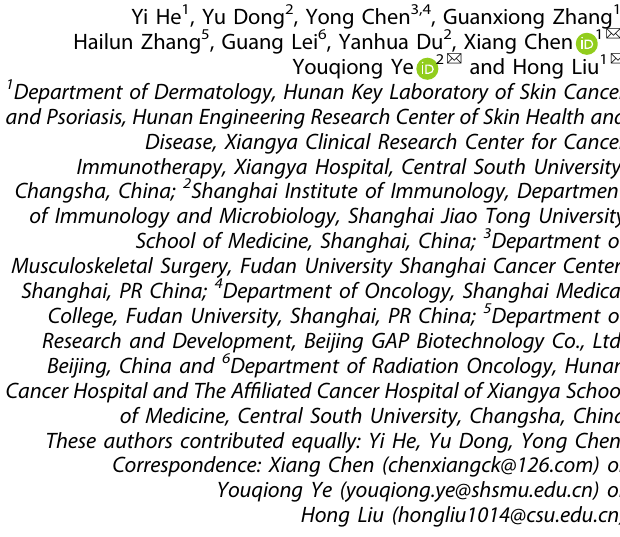
Fig. 1 Comprehensive analyses of ferroptosis: implications for cancer therapeutic liability. a Univariate Cox hazard analysis demonstrated that Ferroptosis Score (FPS) was the top signi fi cant protect factor for overall survival compare with all the 50 hallmarks of cancer in the TCGA-SKCM cohort. b The overview of integrated analysis of multi-omics using propensity score algorithm (PSM) and drug response. c The number of each signi fi cant altered molecular feature identi fi ed by PSM in the high-FPS group and the low-FPS group from TCGA-SKCM samples. d